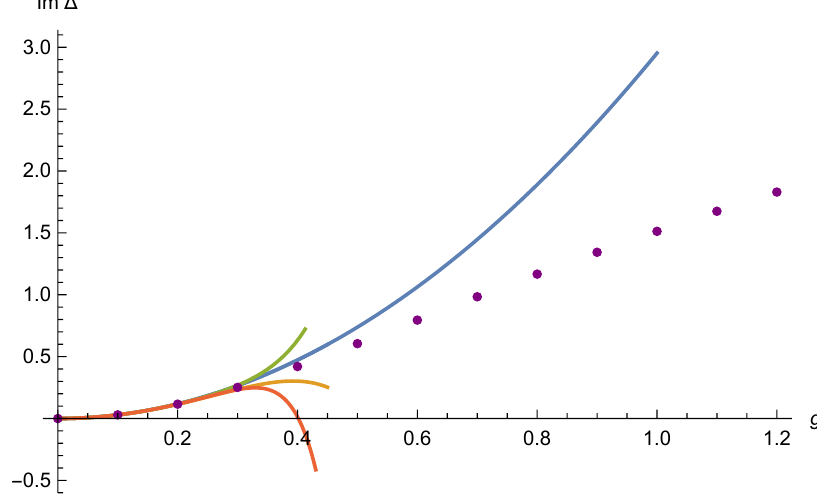
Figure 1 . Numerical results for the scaling dimension of the Tr ( φ 1 φ 1 ) operator at finite coupling. We plot Im ∆ as a function of the coupling g . Purple dots show numerical data obtained by solving the QSC. We also show the analytic weak coupling result to order g 2 , g 6 , g 8 and g 10 as the curves colored blue, yellow, green and red correspondingly. The higher the order, the better they agree with data at weak coupling, while the opposite is true for large coupling.